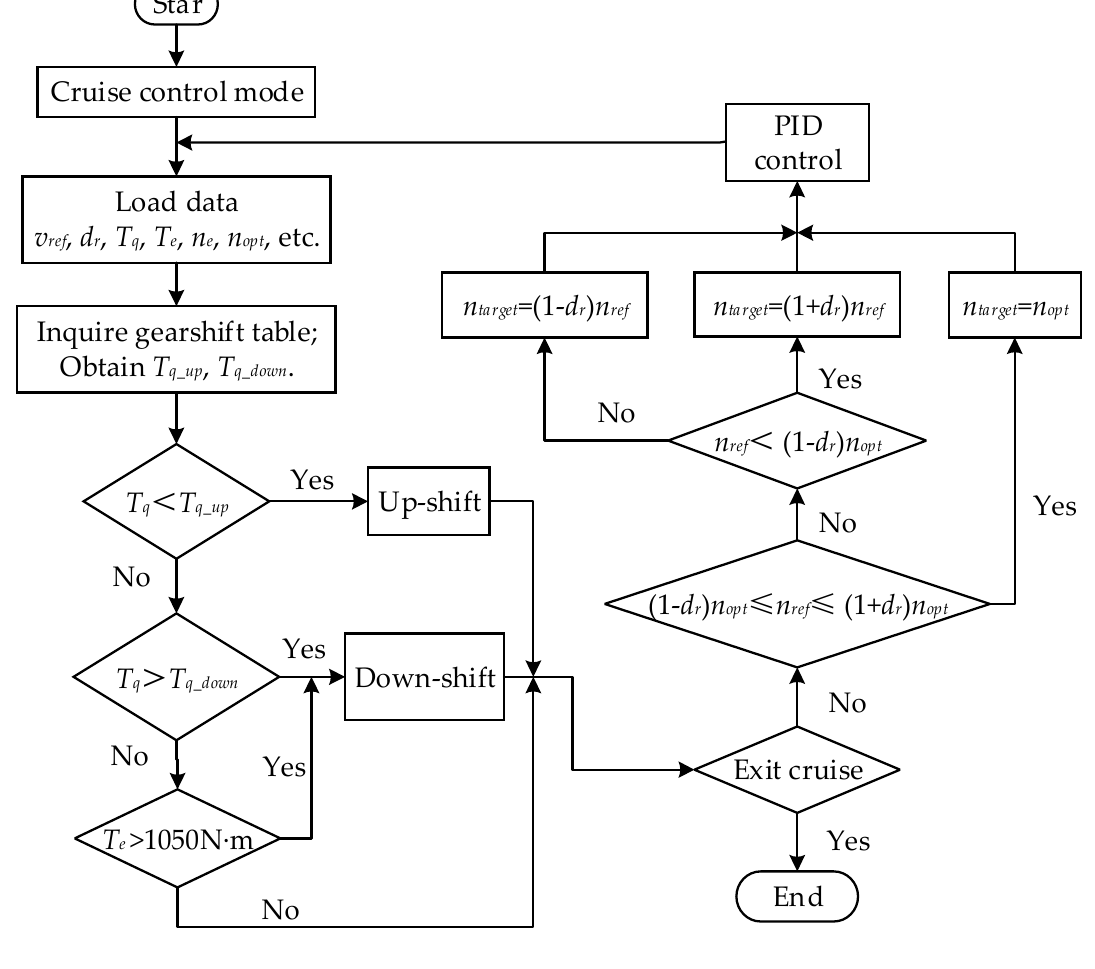
Figure 11. Control flow of cruise control.